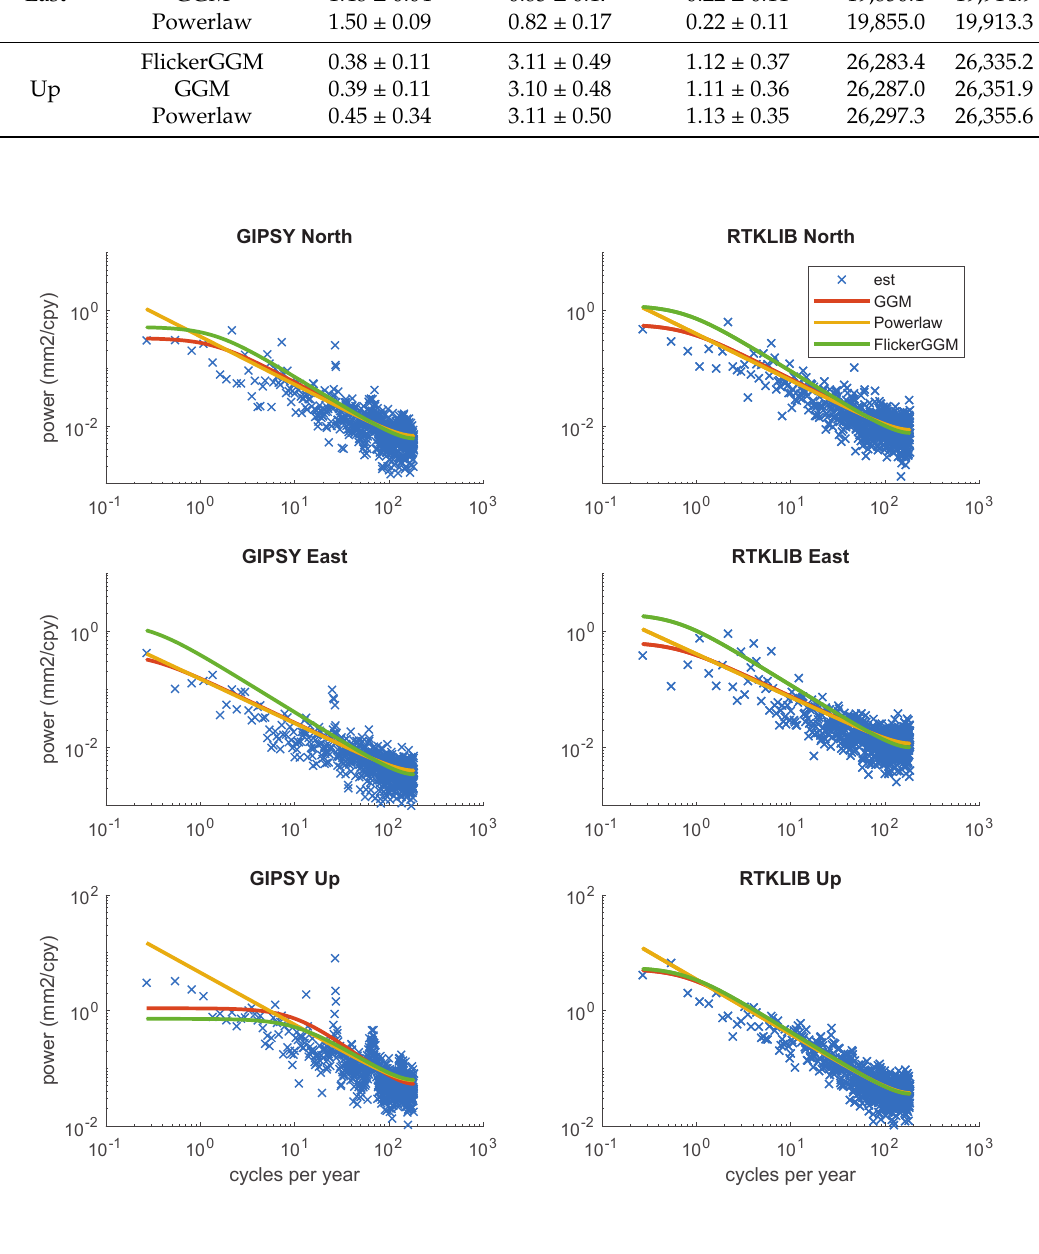
Figure 11. Power spectral density plots for both solutions and all components. Aboa coordinate time series contain temporally correlated coloured noise which spectral index is closer to flicker noise. The noise of the horizontal components is characterised by an average spectral index κ = − 0.8 and average amplitude of 5 mm/y 0.20 , whereas the noise of the vertical component has similar nature κ = − 0.9 but three times larger amplitude, i.e. 16 mm/y 0.22